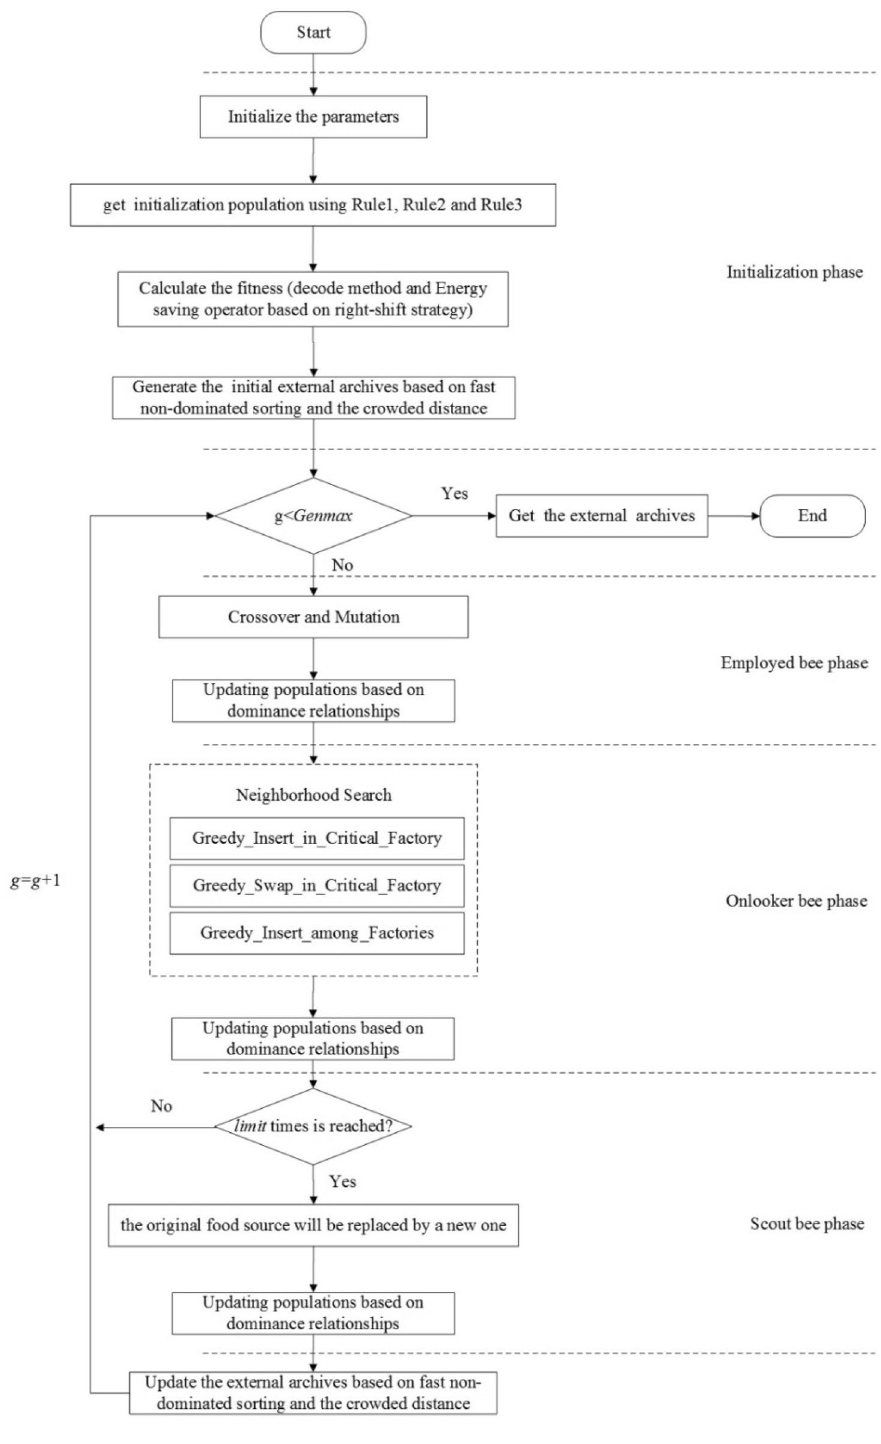
Figure 2. Flow chart of MOABC algorithm.